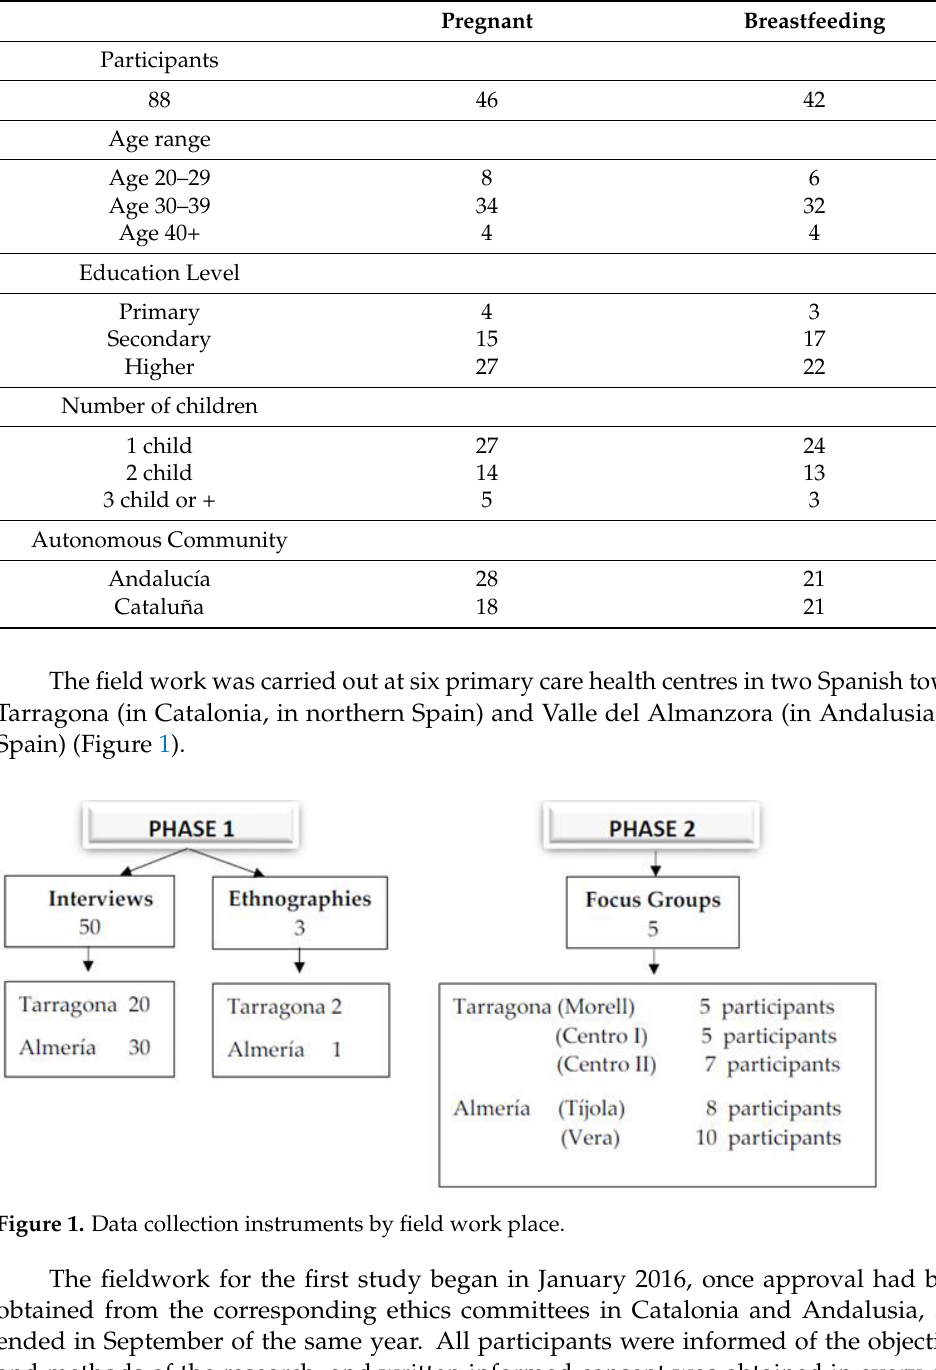
Table 1. Characteristics of the pregnant and breastfeeding women participants.